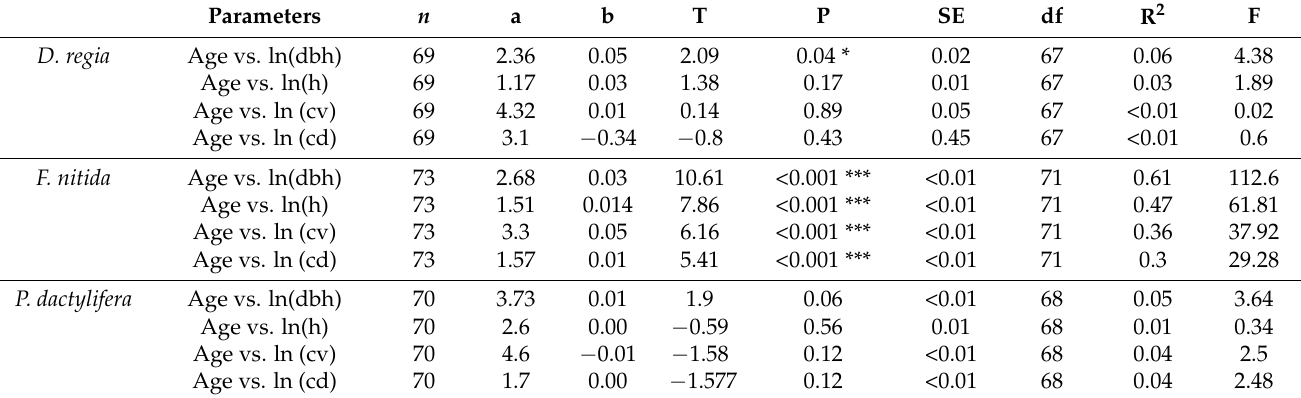
Table 3. Allometric linear relationships between age and tree height, crown diameter, and crown vol- ume as a response, and the regression equation for F. nitida , D. regia , and P. dactylifera . Abbreviations: (dbh) diameter at breast height; (h) tree height; (cd) crown diameter; (cv), crown volume; regression coefficients (a, b); coefficients of determination (R 2 ); standard errors (SE); and F-values, as well as P for p -value (with levels of significance indicated by symbols such as *** and